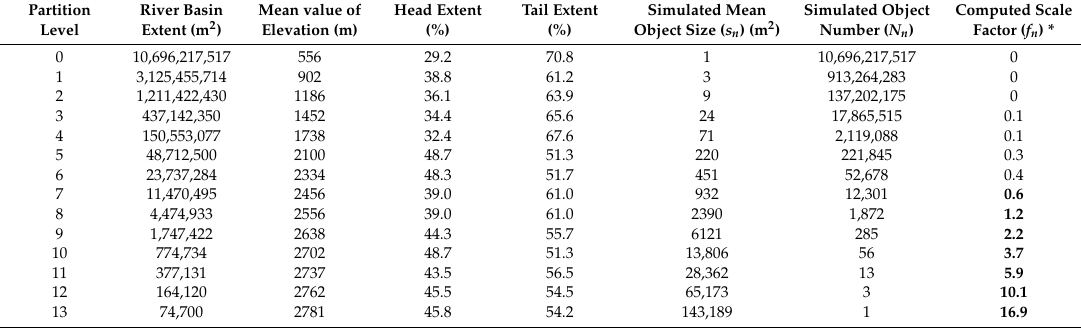
Table 3. Partial and final outputs for elevation in the Pinios river basin; 0-partition level corresponds to the original elevation surface.